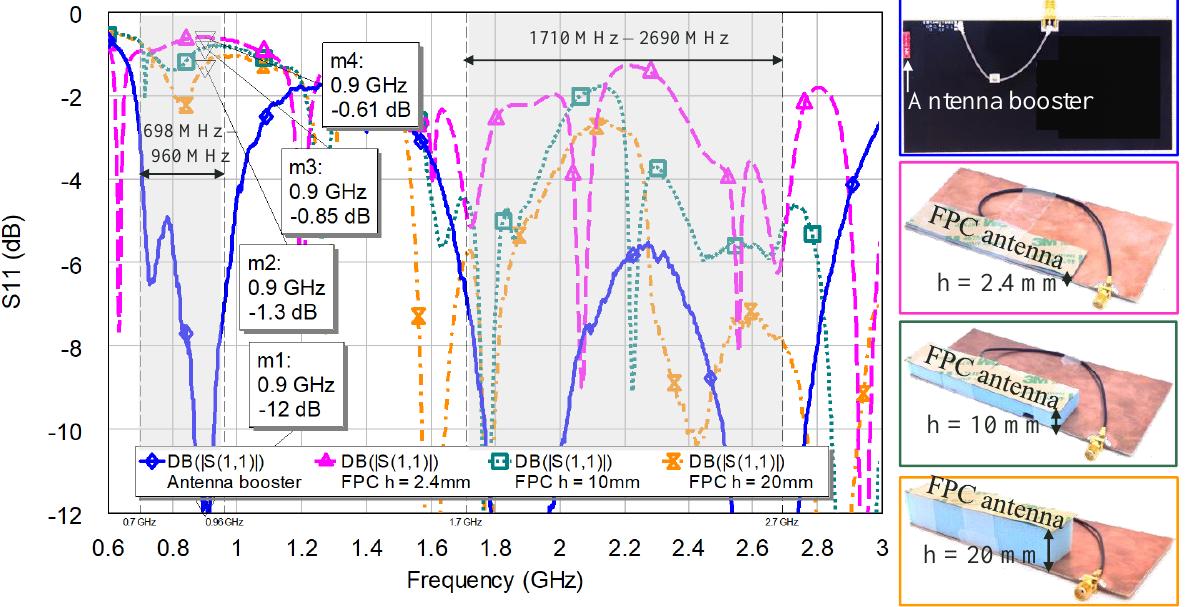
Figure 15. Measured S 11 for the 12 mm × 3 mm × 2.4 mm (h) antenna booster and FPC at three different heights over the ground plane (2.4 mm, which is the same height as the antenna booster, 10 mm and 20 mm). PCB is 131 mm × 60 mm.